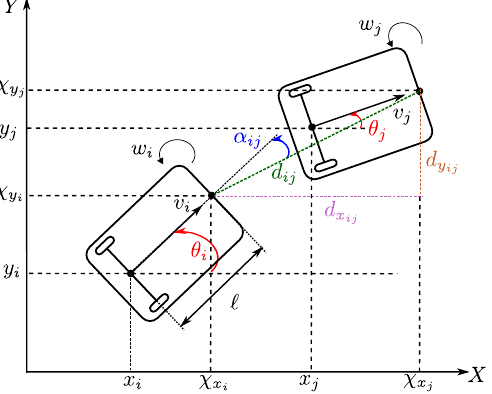
Figure 1. Schematic diagram of two differential-drive wheeled mobile robots in the leader–follower